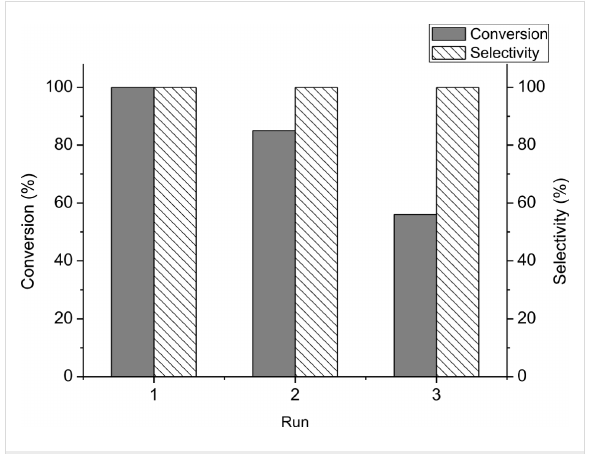
Figure 3: Reusability of the Na 2 PdCl 4 / L1 catalytic system for the cata- lytic Mizoroki–Heck coupling reaction of 4-bromoacetophene ( 1a ) and styrene ( 2a